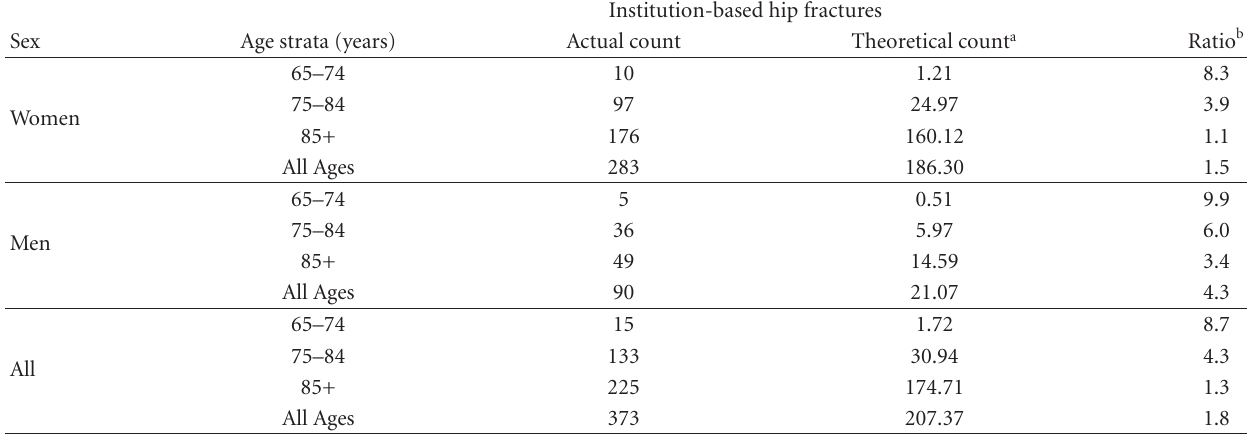
Table 2: Actual and theoretical incidence of hip fractures in non-community settings by sex and age in the city of London, ON, 2002–2006.